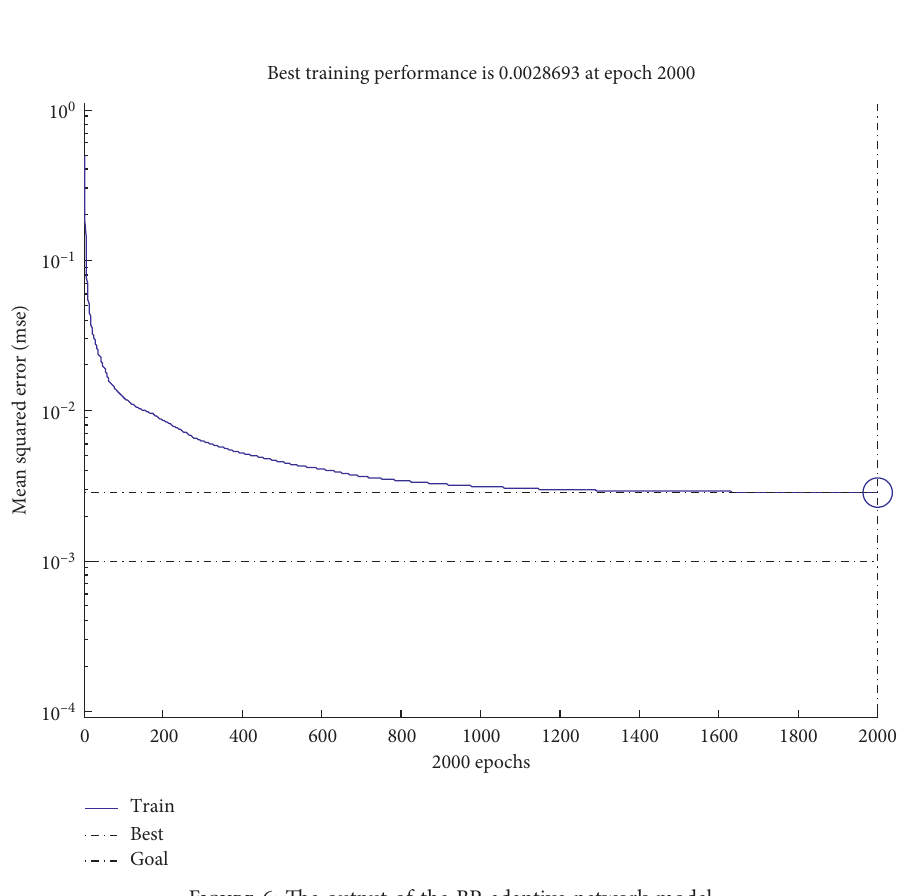
Figure 6: The output of the BP-adaptive network model.